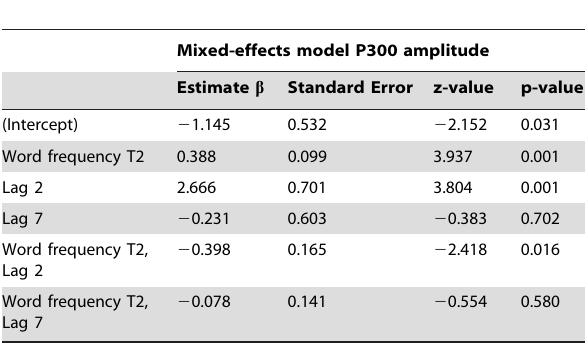
Table 5. The estimates and z-values of the mixed-effects model for P300 amplitude (only correct trials are